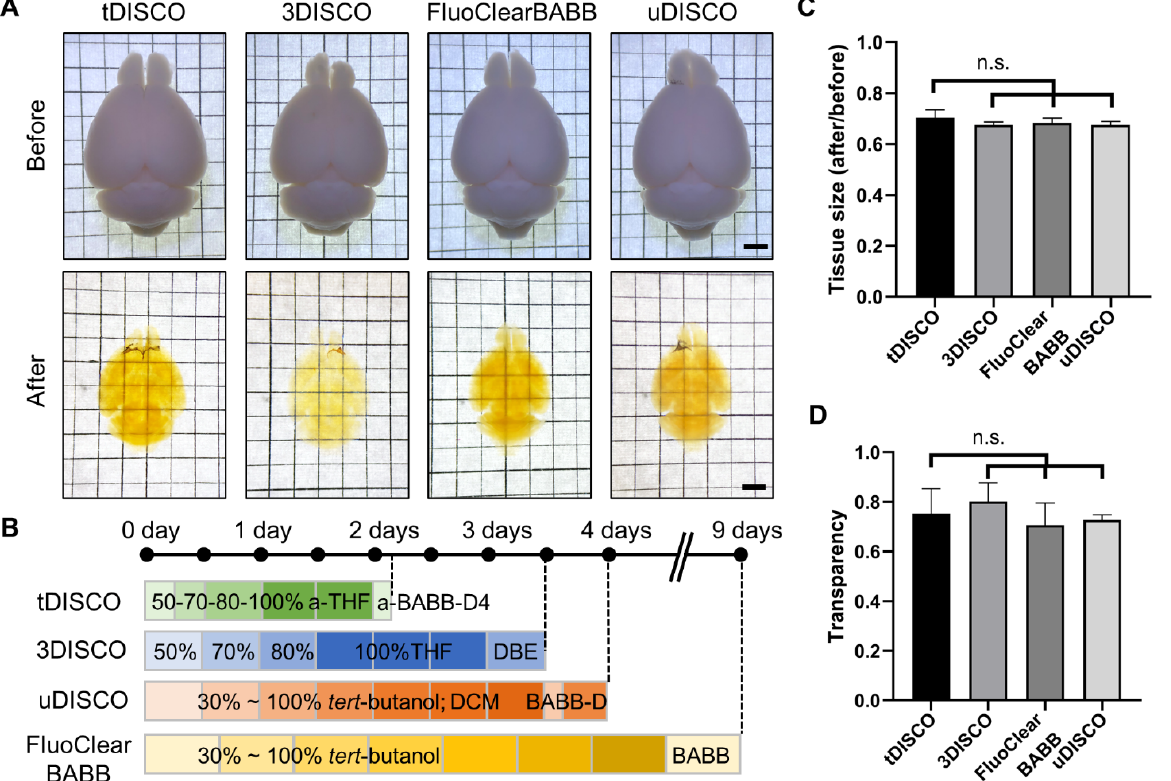
Figure 2. Comparison of the clearing performance on the adult whole brain of tDISCO and other solvent-based clearing methods. ( A ) Images of the whole brain before and after clearing. ( B ) The clearing processes and timelines for the adult whole brain by each clearing method. ( C ) The brain size change after tDISCO, 3DISCO, FluoClearBABB, and uDISCO clearing ( n = 5 brains for each method). ( D ) Transparency of the whole brain after tDISCO, 3DISCO, FluoClearBABB, and uDISCO clearing ( n = 5 brains for each method). Scale bars: 2 mm. All data are shown as means ± SD. n.s., not significant.